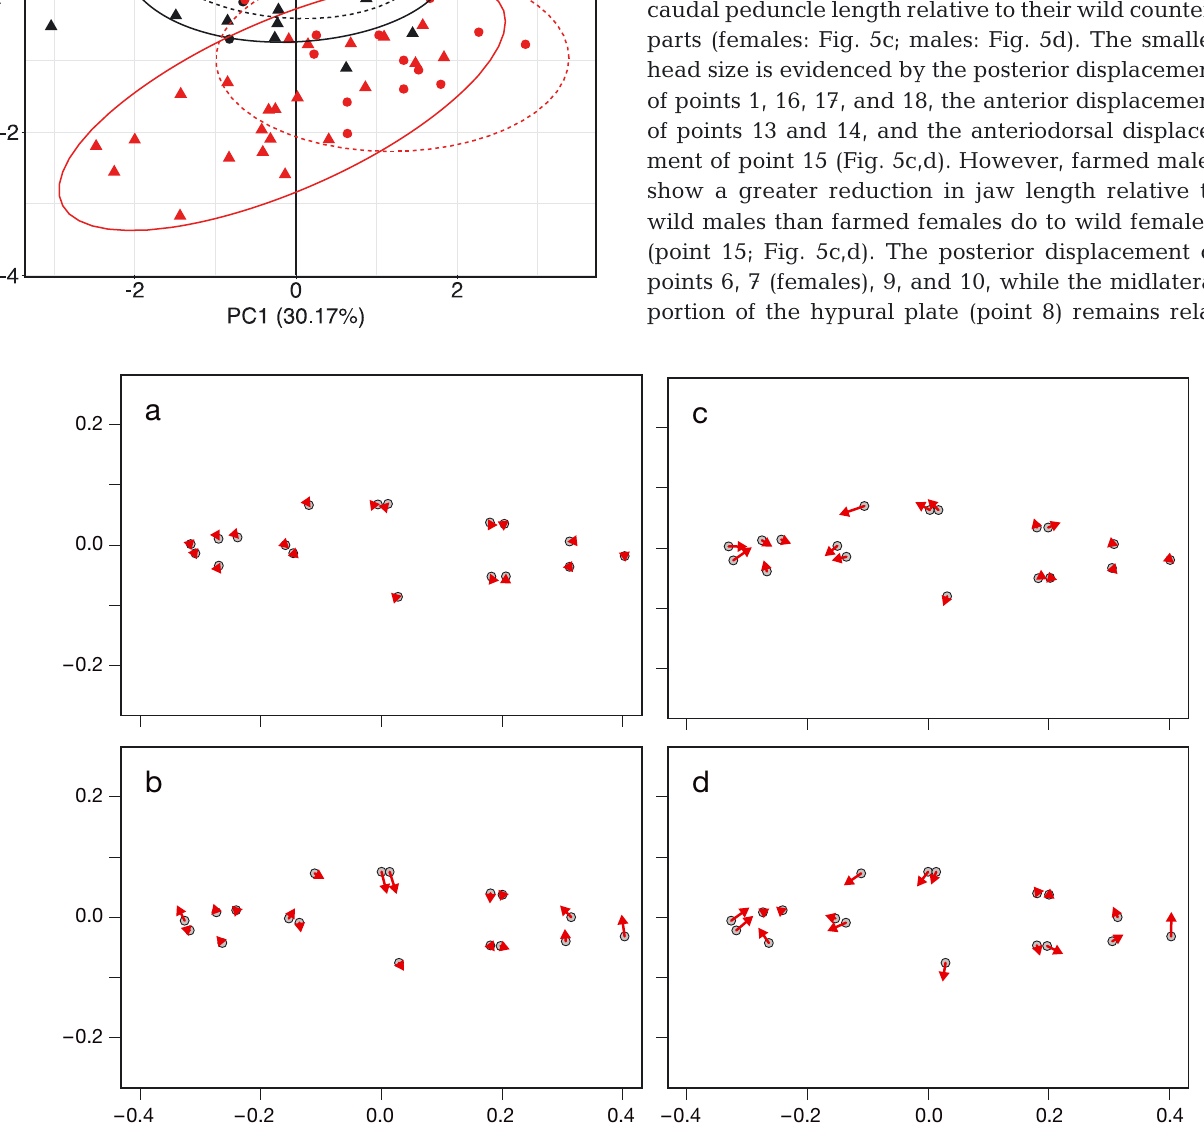
Fig. 5. Magnitude and displacement of the consensus shapes of Gadus morhua : (a) farmed females (n = 50) relative to farmed males (n = 58); (b) wild females (n = 23) relative to wild males (n = 13); (c) farmed females relative to wild females; (d) farmed males relative to wild males. The direction and degree of displacement (red arrow) of the landmarks of the consensus shape of the first group is shown relative to the location of landmarks on the consensus shape of the second group ( ds ). The landmark numbering in (b−d) is the same as that in (a), and landmark numbers and descriptions are given in Fig. 2. Displacements have been magnified 3× for easier visualization. Units for both the x- and y- axes are the Procrustes